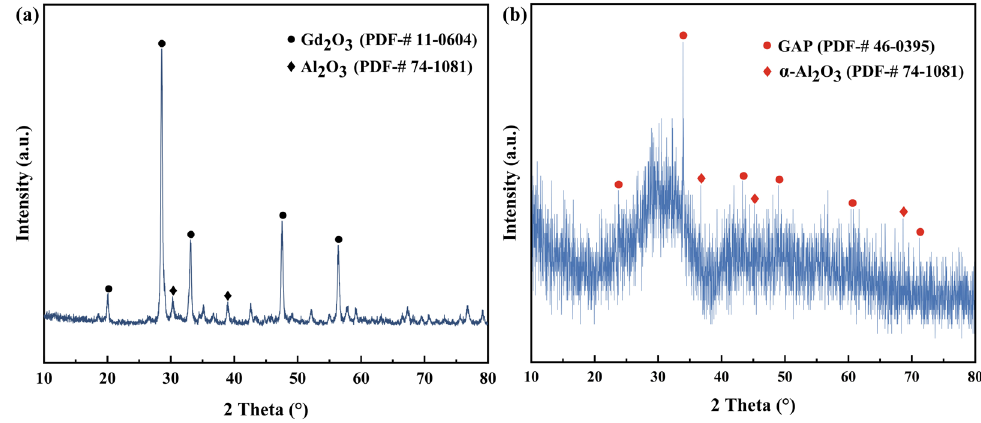
Figure 4. XRD pattern of ( a ) Al 2 O 3 /Gd 2 O 3 granulated powder and ( b ) as-sprayed Al 2 O 3 -GAP coating.